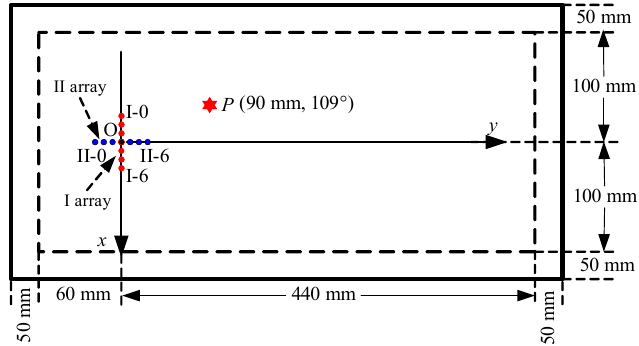
Figure 9. The locations of the piezoelectric elements and single damages.